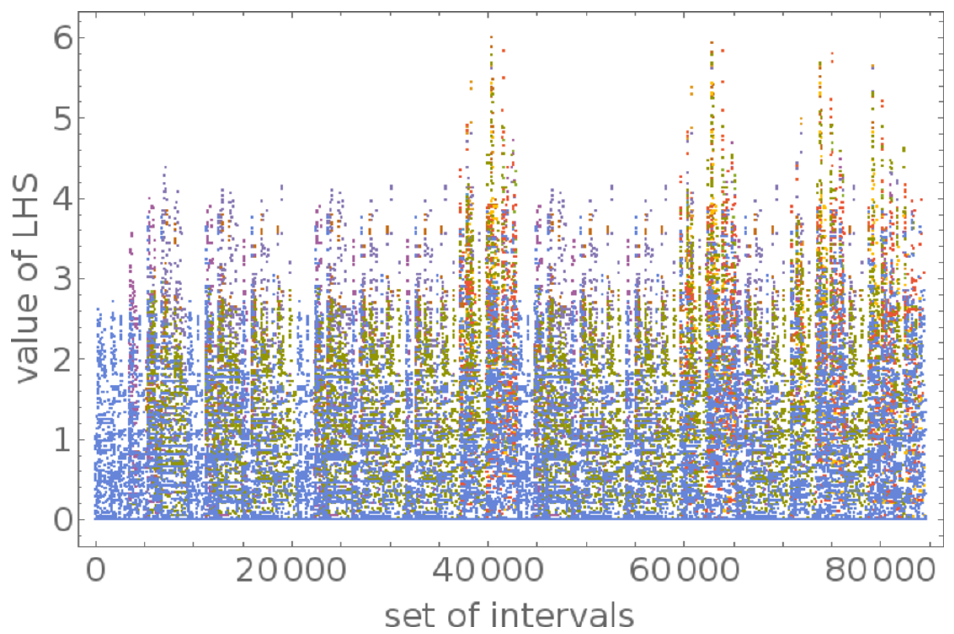
Figure 22 . The left-hand sides of the inequality (6.13) for the 84579 sets of (cid:12)ve intervals (out of initially 184756) for which the total entanglement entropy is not in the totally disconnected phase. Clearly there are no violations of the inequality (6.13). The di(cid:11)erent colors in the (cid:12)gure stand for di(cid:11)erent permutations, as explained in section 6.3. As in (cid:12)gure 20, we are here displaying results for the example where T L = 9, T R = 1 and the boundary time t = 1.